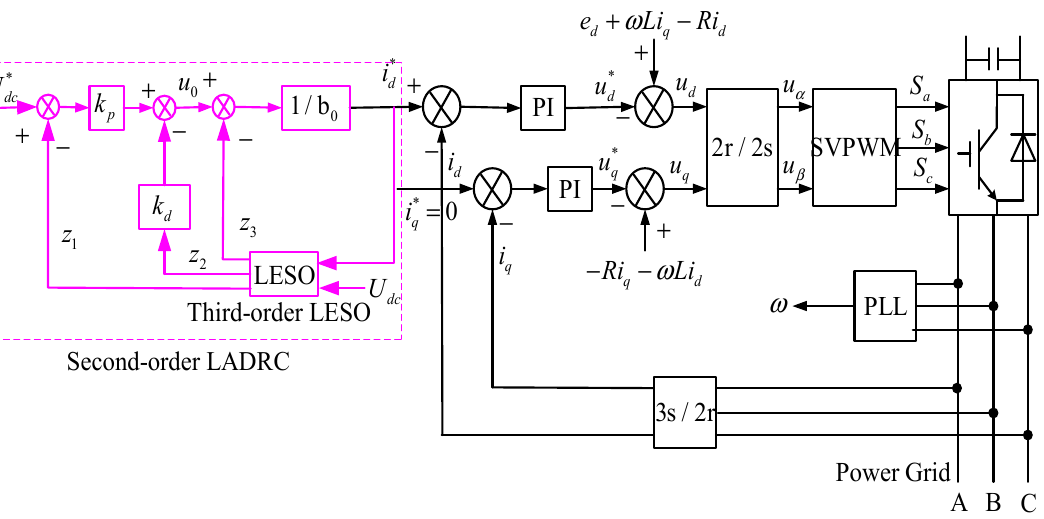
Figure 7. Control block diagram of voltage outer loop grid-connected inverter based on second-order LADRC.